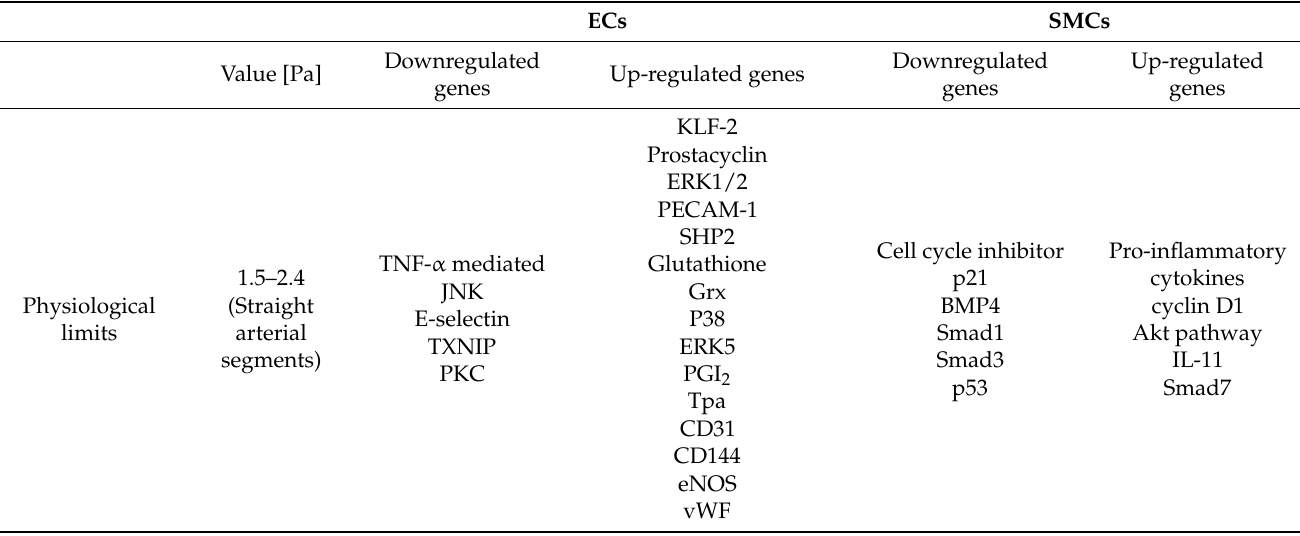
Table 4. Effect of baseline, low and critically high shear stress over EC, SMCs and macrophages.